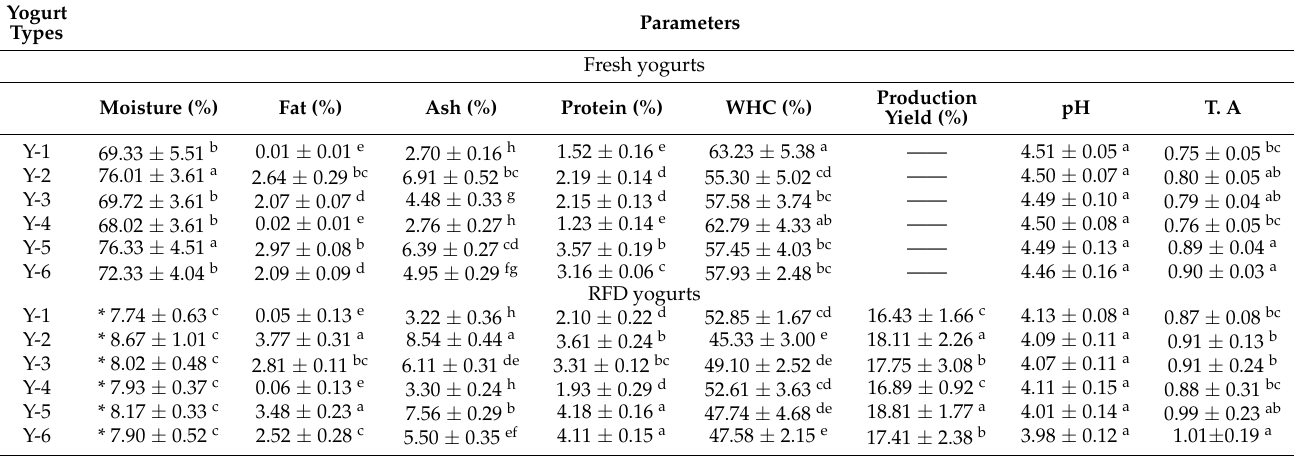
Table 2. Physicochemical properties, production yield and acidification properties of fresh and RFD yogurts. Yogurt Types Parameters Fresh